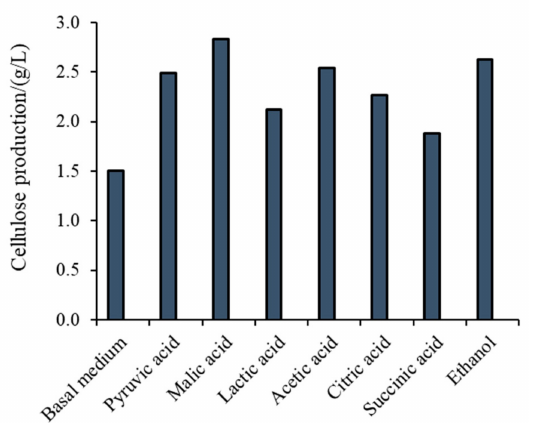
Figure 2. Influence of di ff erent organic acids and ethanol on cellulose yield. Reproduced from [21] with permission from Research & Reviews: Journal of Microbiology and Biotechnology,